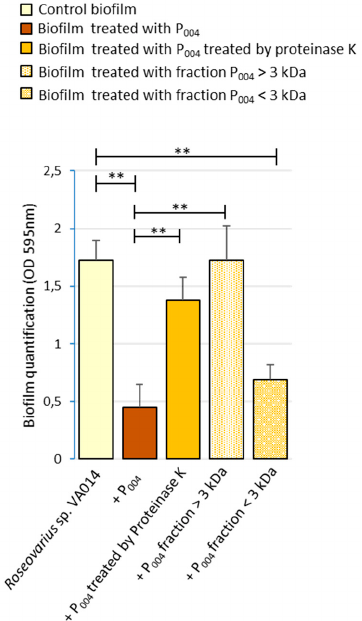
Figure 7. E ff ect of proteinase K treatment on the P 004 anti-biofilm compound purified from SN IIIA004 and molecular weight evaluation. Microtiter plate assay was used. P 004 was either treated with proteinase K or filtered in a Centricon tube with a 3 kDa Nominal Molecular Weight Limit (NMWL) ( > 3 kDa: retentate; < 3 kDa: filtrate). Control biofilm: Roseovarius sp. VA014 biofilm treated with Zobell broth instead of SN IIIA004 . Significant di ff erences are indicated by ** ( p <